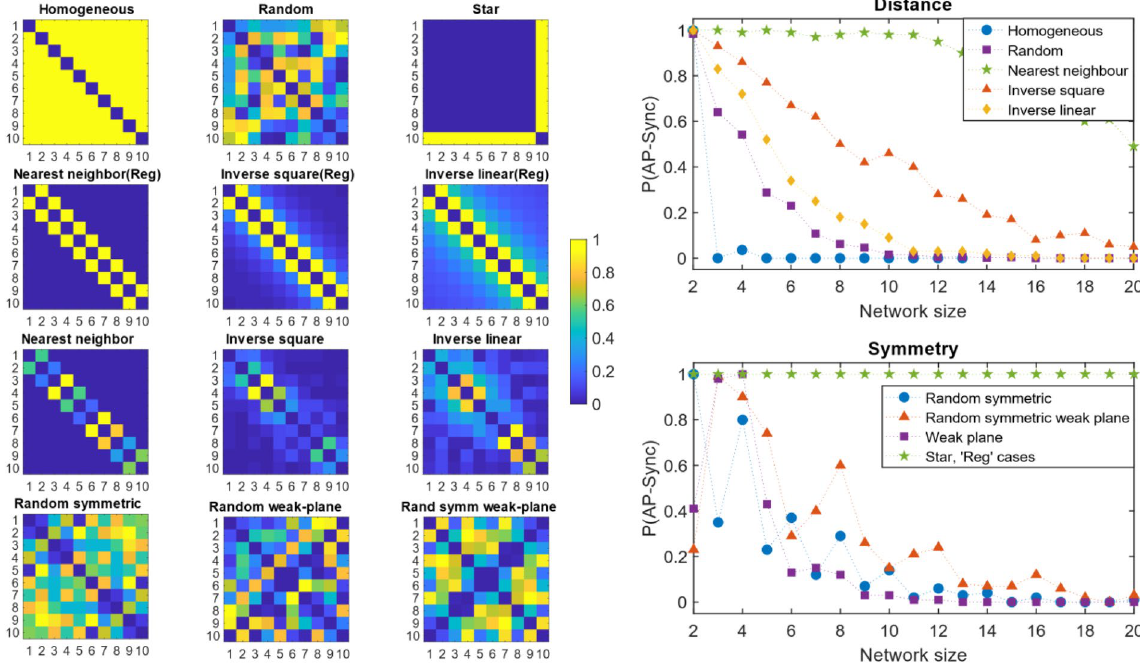
Figure 5. Effects of structure – symmetry and distance of coupling. The color matrices are plotted using the adjacency matrices of the networks, where the color represents the edge strength between nodes i and j . Since the networks are undirected, all matrices are symmetric about the main diagonal. Symmetry in the network implies the adjacency matrix is bisymmetric (last row). The results show that symmetry enhances AP synchronization slightly. Coupling is varied as a function of distance for initially homogeneous (Reg) and random networks (see Methods). The star topology and regular cases give perfect AP synchronization regardless of network size. For random networks, nearest neighbor coupling allows the best chances of AP synchronization. As the interaction persists longer over distance, probability of AP synchronization